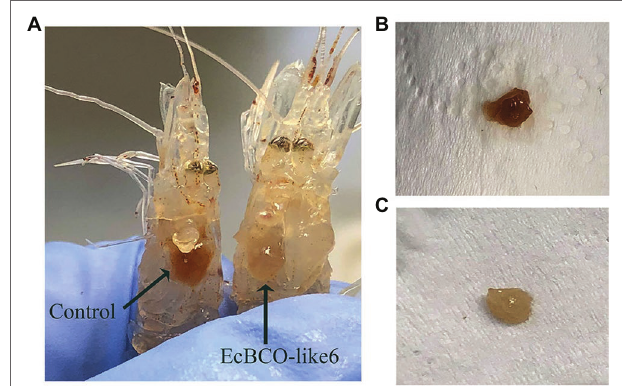
FIGURE 5 | The color changes of hepatopancreas in prawns after dsEcBCO-like6 injected. (A) represents the prawns in the control group and dsEcBCO-like6 injected group; (B) shows the hepatopancreas of prawns in the control group feeding the same carotenoid; (C) represents the hepatopancreas of prawns in the EcBCO-like6 group.